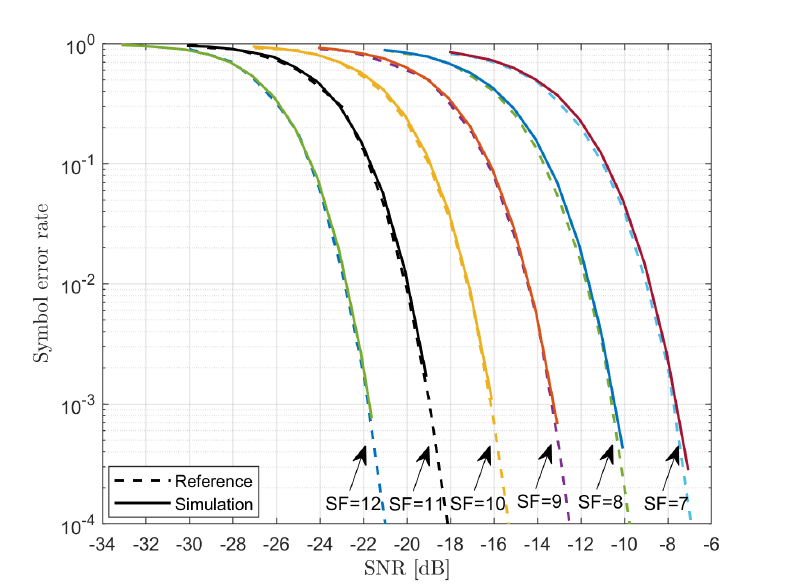
Figure 4. Symbol error rate vs. SNR